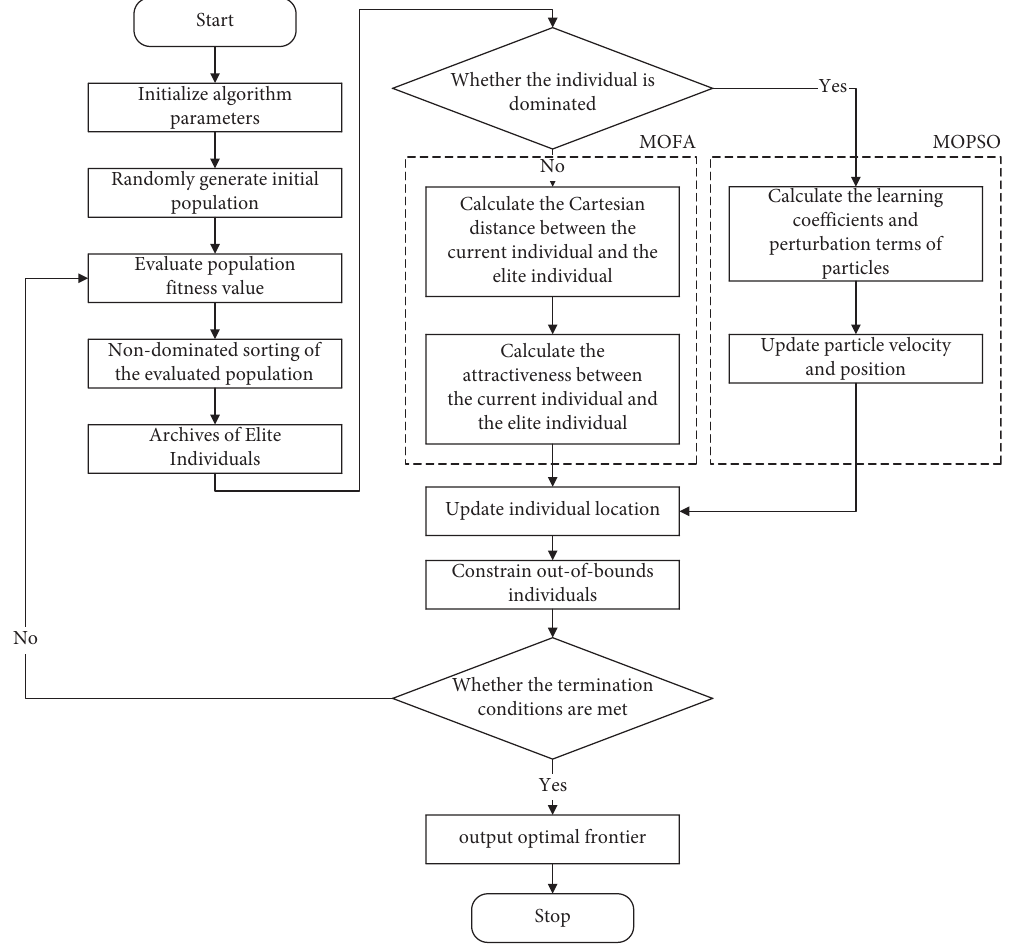
Figure 1: Te operation fow of the